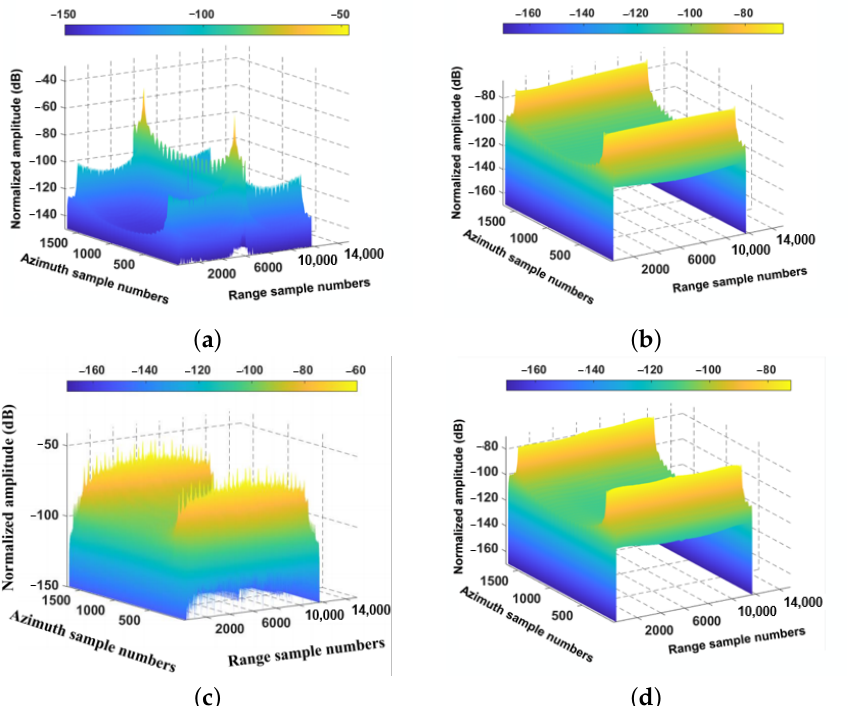
Figure 7. Focusing results (HV polarization channel of a generalized hybrid quad-pol mode) of different transmission scheme (dB) in correspondence of the first azimuth ambiguity portion for: ( a ) up chirp waveform, ( b ) up-down chirp waveforms, ( c ) OFDM chirp waveforms and ( d ) quasi- orthogonal NLFM